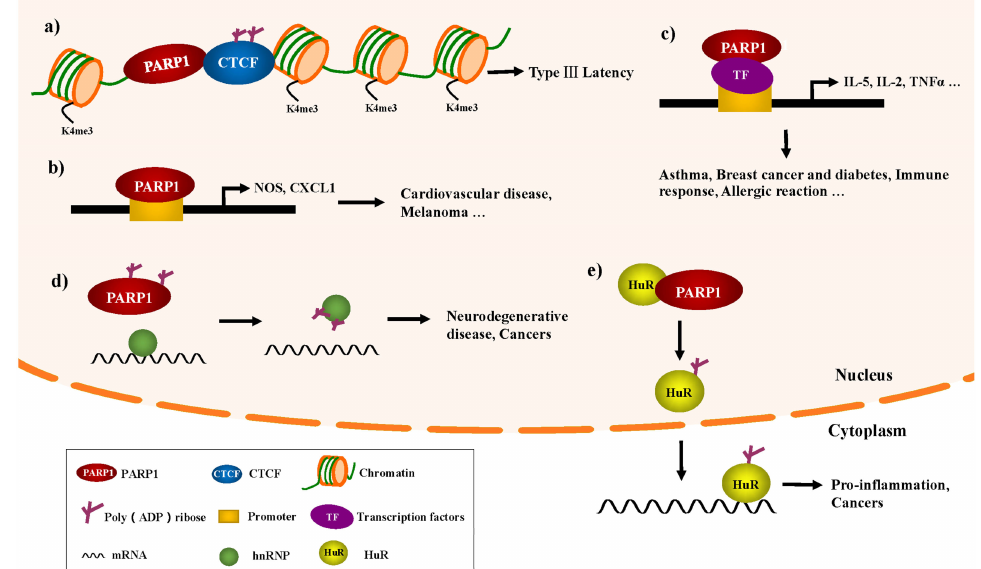
Figure 2. Significance of PARP1 in diseases by regulating gene expression. ( a ) In type III EBV latency, CTCF PARylation by PARP1 acts at the Cp promoter to maintain the open chromatin